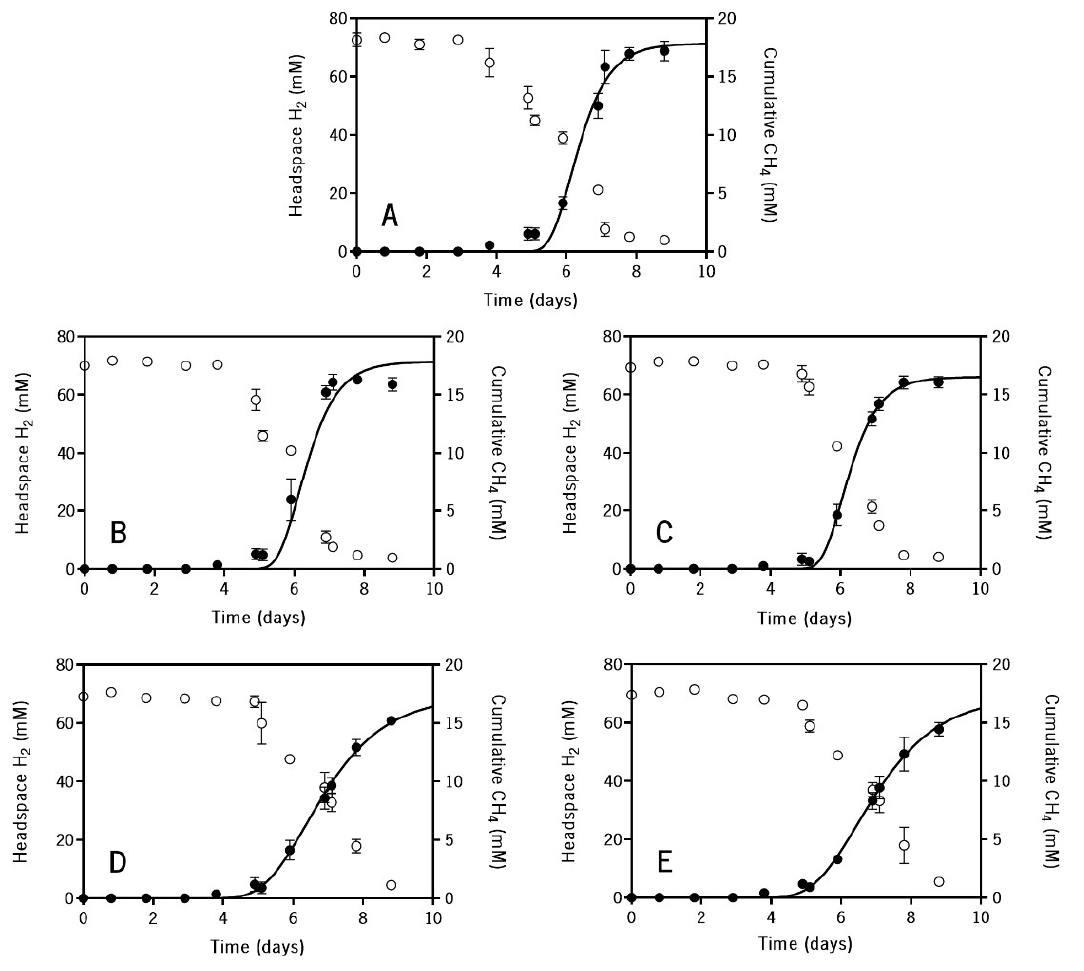
Figure 2. Effects of increasing hexadecane concentrations on H 2 consumption ( ○ ) and cumulative CH 4 production (●) by M. formicicum : ( A )–0 mM, ( B )–1 mM, ( C )–5 mM, ( D )–15 mM, and ( E )–30 mM. The black line represents the fitting of the cumulative methane production data by the modified Gompertz equation.